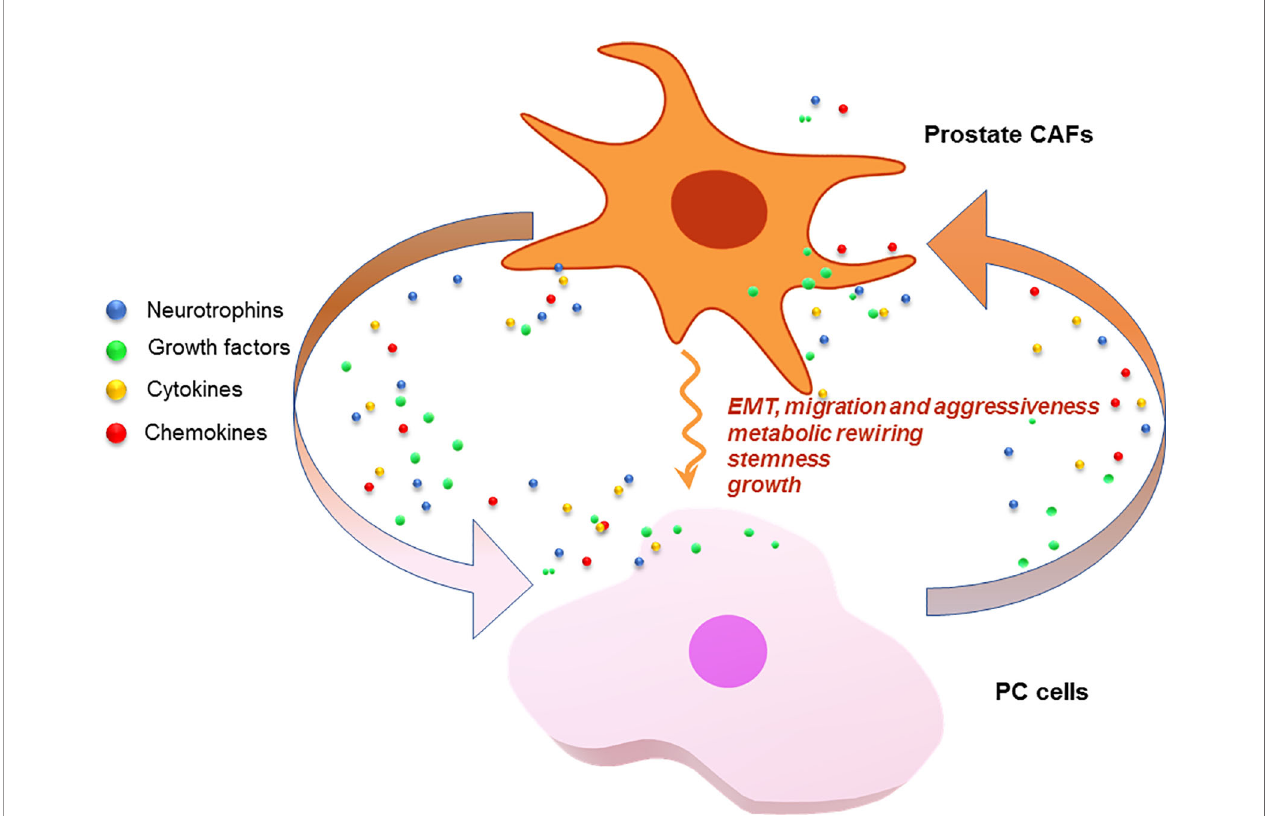
FIGURE 3 | CAFs and PC cells as signal exchangers. CAFs or PC cells release neurotrophins, growth factors, cytokines and chemokines. These signals are exchanged by the cells to foster a plethora of responses that lead to PC progression and